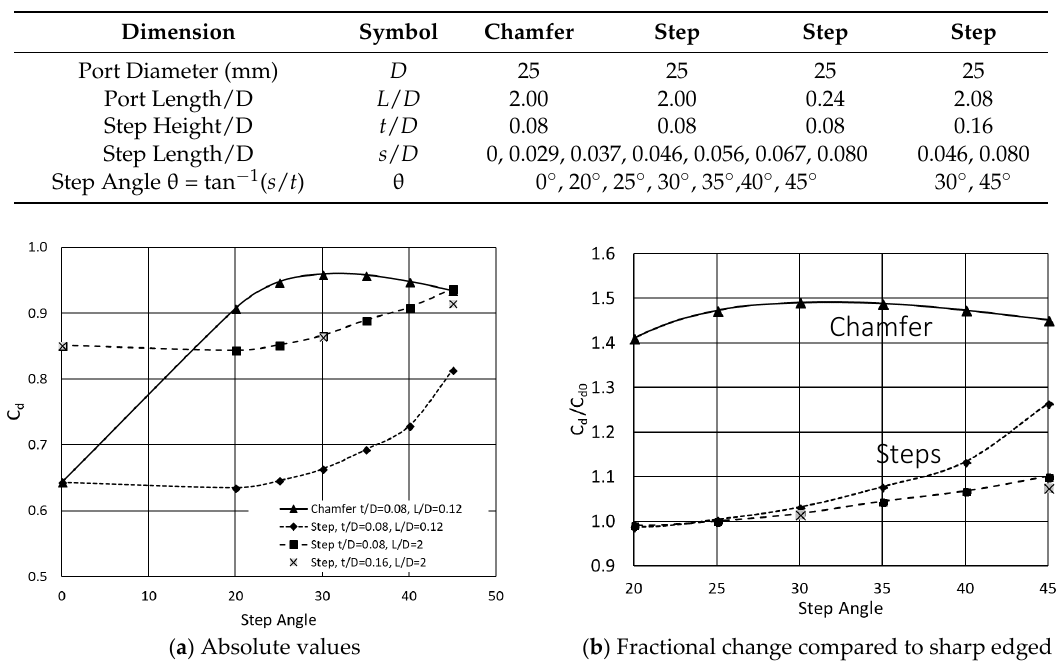
Table 5. Axis ‐ symmetric chamfered and stepped port flow testing configurations, airflow rig. Table 5. Axis-symmetric chamfered and stepped port flow testing configurations, airflow rig.